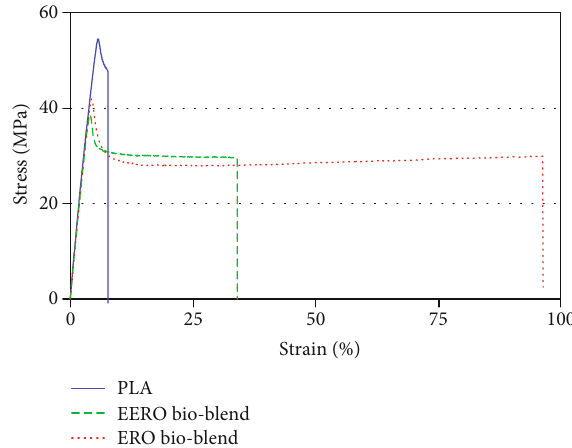
Figure 1: The relationship between stress and strain.